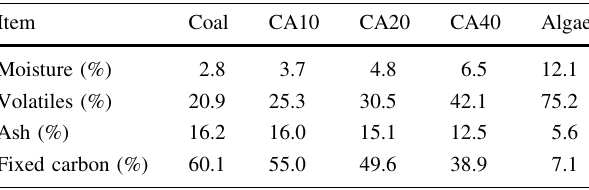
Table 1 Proximate analysis of coal, algae and their blends (as received) Item